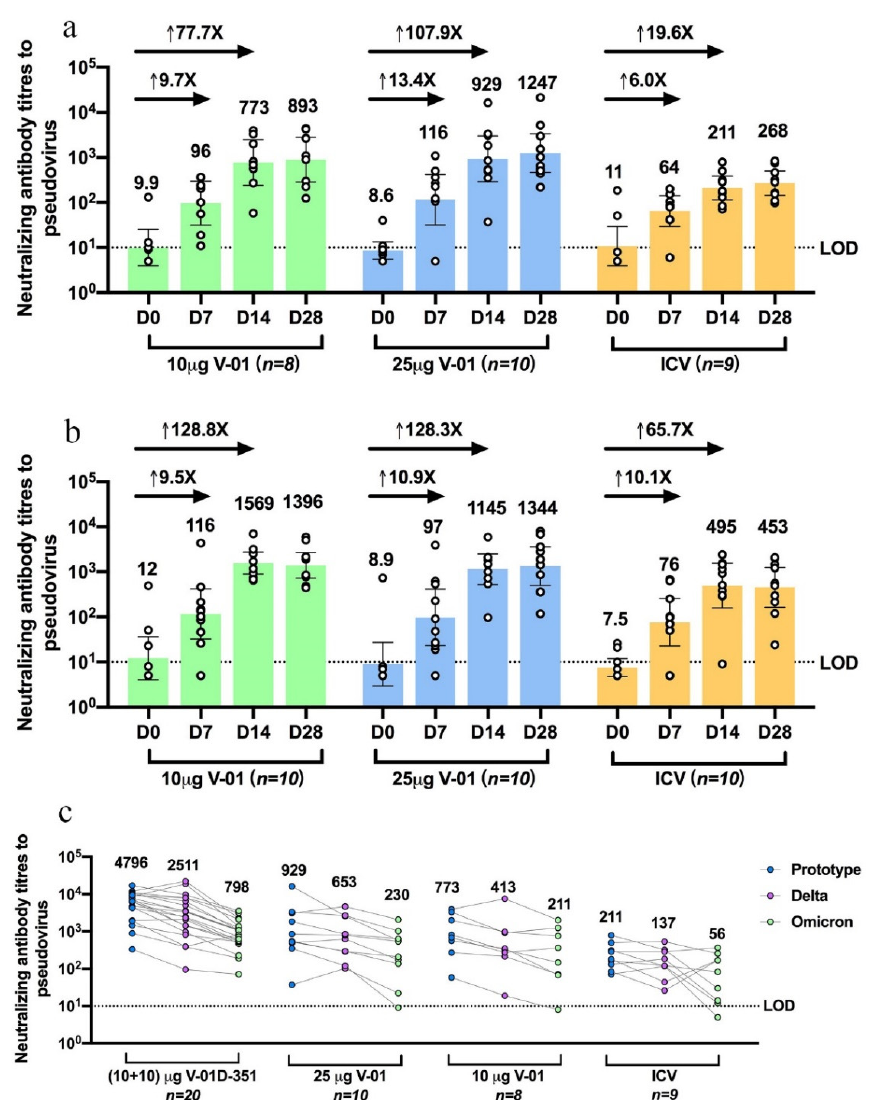
Figure 1. Humoral immune response against prototype SARS-CoV-2, Delta, and Omicron BA.1 strain after V-01 or variant-matched bivalent V-01D-351 booster following primary series of inactivated vaccine. Pseudovirus neutralizing antibody titers against prototype SARS-CoV-2 were analyzed for sera collected at different times (7, 14, 28 days) following a 10 µ g V-01, 25 µ g V-01, or inactivated vaccine booster in younger adults aged 18–59 years ( a ) or older adults aged ≥ 60 years ( b ). These participants had been primed with two-dose inactivated vaccine 5–7 months earlier. ( c ) Pseudovirus neutralizing antibody titers against prototype SARS-CoV-2, Delta, and Omicron BA.1 strains were analyzed and compared for sera collected from subjects at 14 days following booster of V-01D-351 (individuals in study NCT05273528), 25 µ g V-01, 10 µ g V-01, or inactivated vaccines (younger